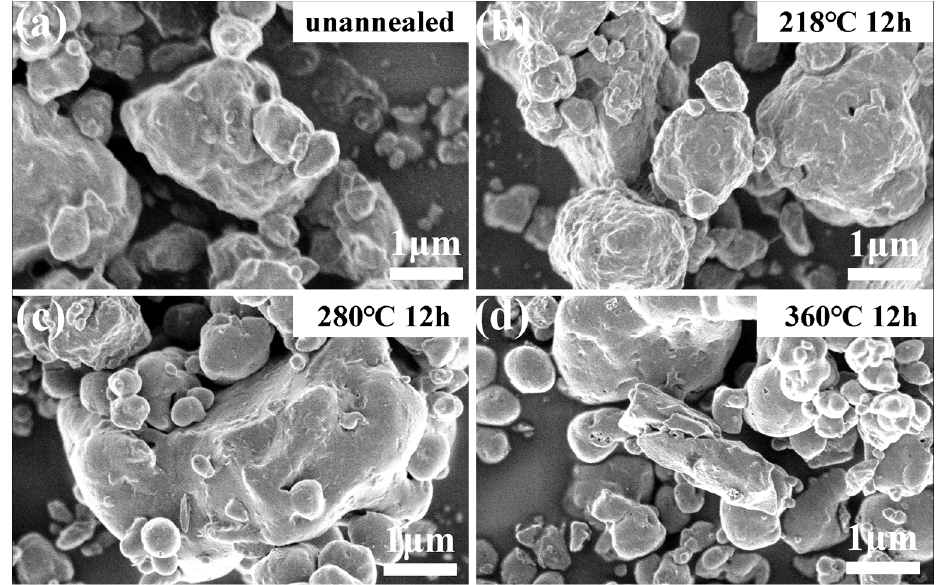
Figure 6. FE-SEM images of ( a ) unannealed LVBB10, ( b ) LVBB10-218, ( c ) LVBB10-280 and ( d ) LVBB10-360. The samples in ( b – d ) were obtained by heat-treating LVBB10 in a tube furnace with an argon atmosphere for 12 h at 218 °C, 280 °C, and 360 °C, respectively. 2.4. Electrochemical Properties of Li 2 O-V 2 O 5 -B 2 O 3 -Bi 2 O 3 Glass-Ceramic